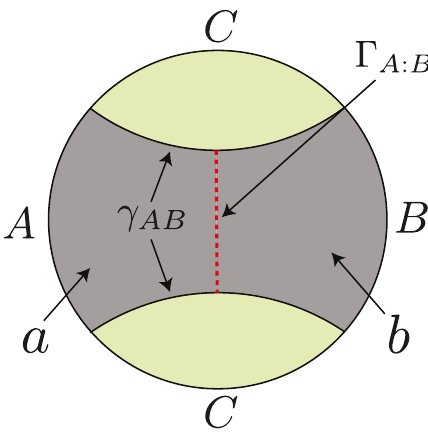
Figure 2 . A spatial slice of AdS with A and B chosen to be two intervals. The figure depicts the entanglement wedge of AB (gray), the entanglement wedge of C (green), the RT surface γ AB and the entanglement wedge cross section Γ A : B , which divides the entanglement wedge into regions a and b homologous to A and B